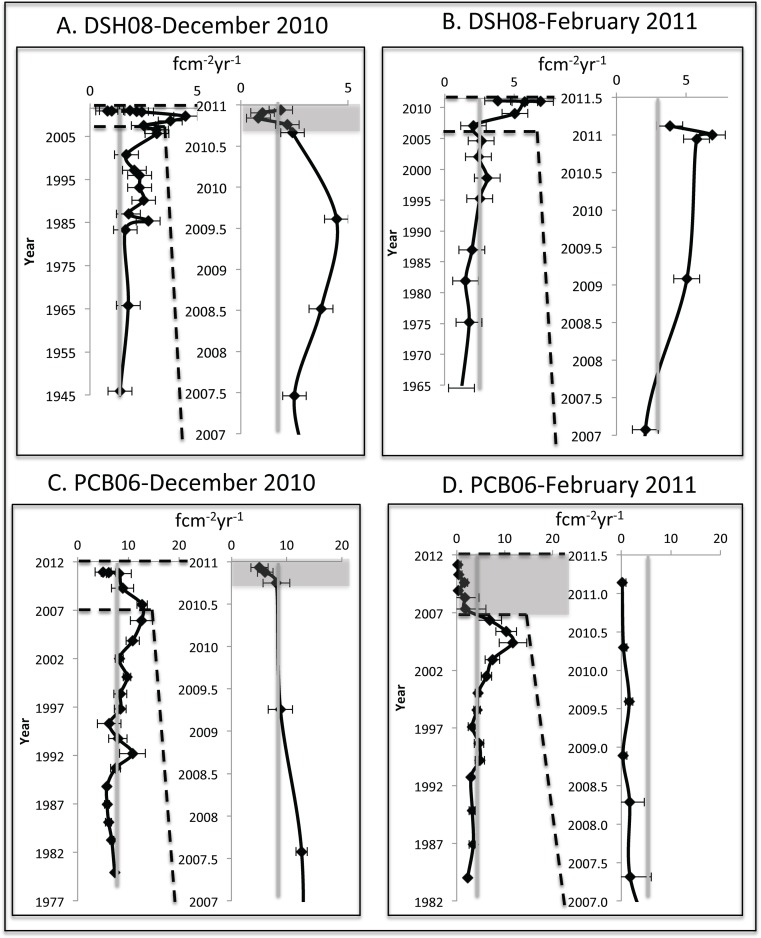
Benthic foraminiferal accumulation rate (BFAR) records for each sampling site with the period from 2007–2011 expanded for examination of the period during and after the DWH event.The gray areas represent the decline in BFAR and the gray lines represent the down-core mean BFAR.